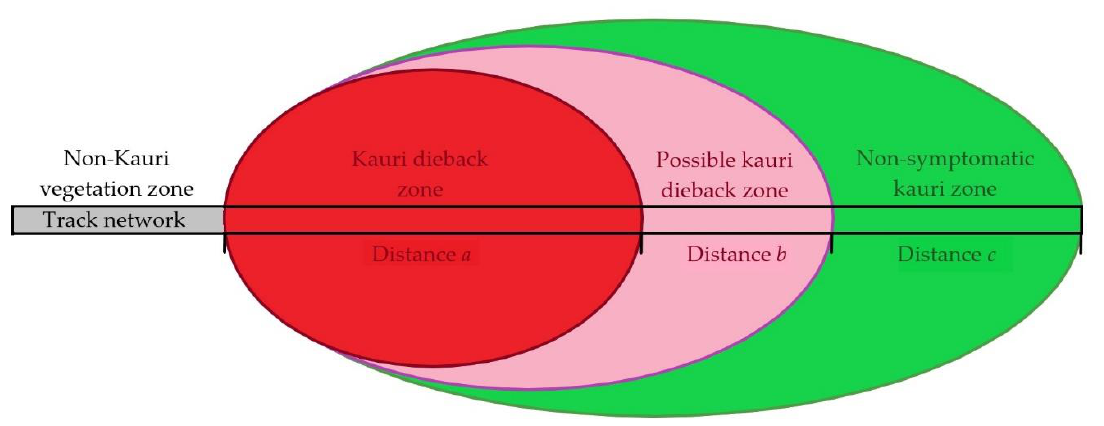
Figure 1. Interpretive display of simulated track analysis, with distances measured of the Kauri dieback zone (distance a), possible kauri dieback zone (distance b) and non-symptomatic kauri zone (distance c).